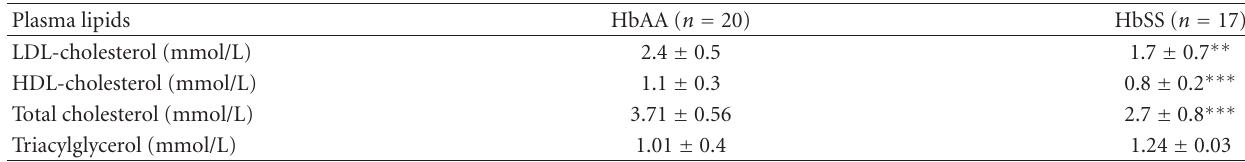
Table 2: Plasma lipid concentrations of steady state HU treated HbSS sickle cell patients and HbAA healthy controls. Plasma lipids